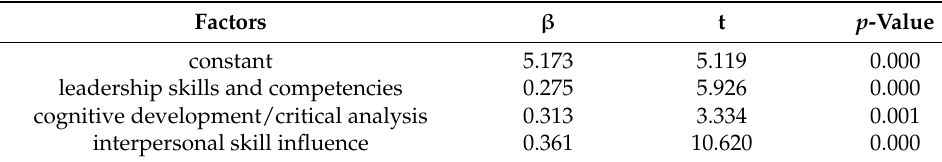
Table 7. Factors influencing innovative